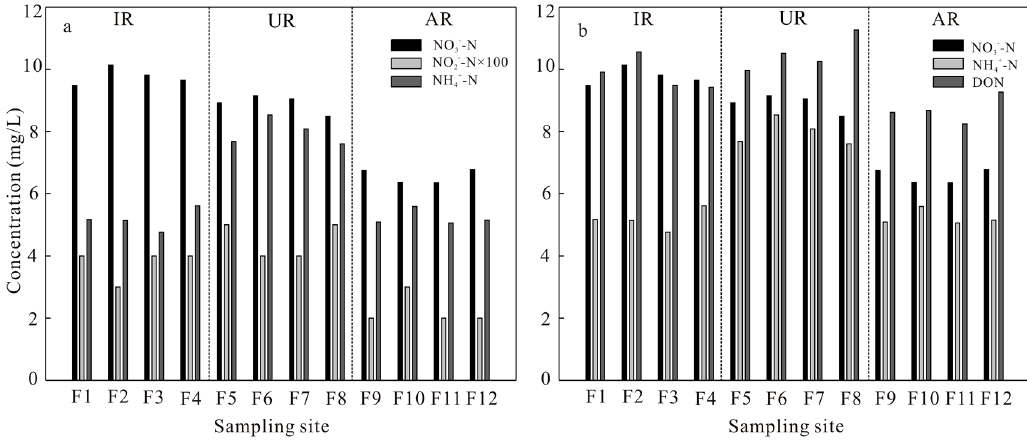
Figure 2. The contrast between nitrogenous species concentration in the lower reach of Fenhe River: ( a ) NO 3 − –N, NO 2 − –N × 100, and NH 4+ –N; ( b ) NO 3 − –N, NH 4+ –N, and dissolved organic nitrogen (DON). ( a ) NO − –N, NO − –N × 100, and NH 4+ –N; ( b ) NO 3 2